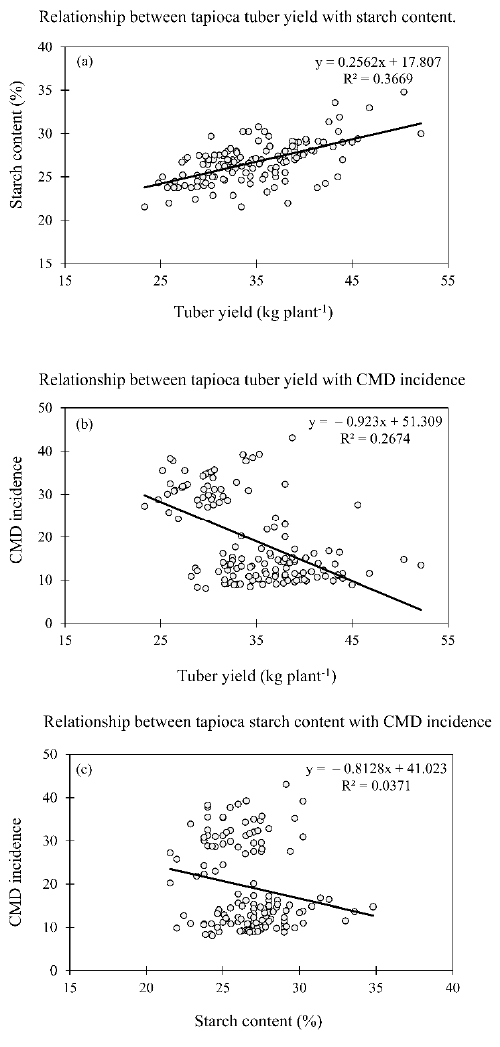
Figure 2. Relationship among cassava tuber yield, starch, and CMD incidence. ( a ) tuber yield vs. starch content, ( b ) tuber yield vs. CMD incidence, and ( c ) starch content vs. CMD incidence.